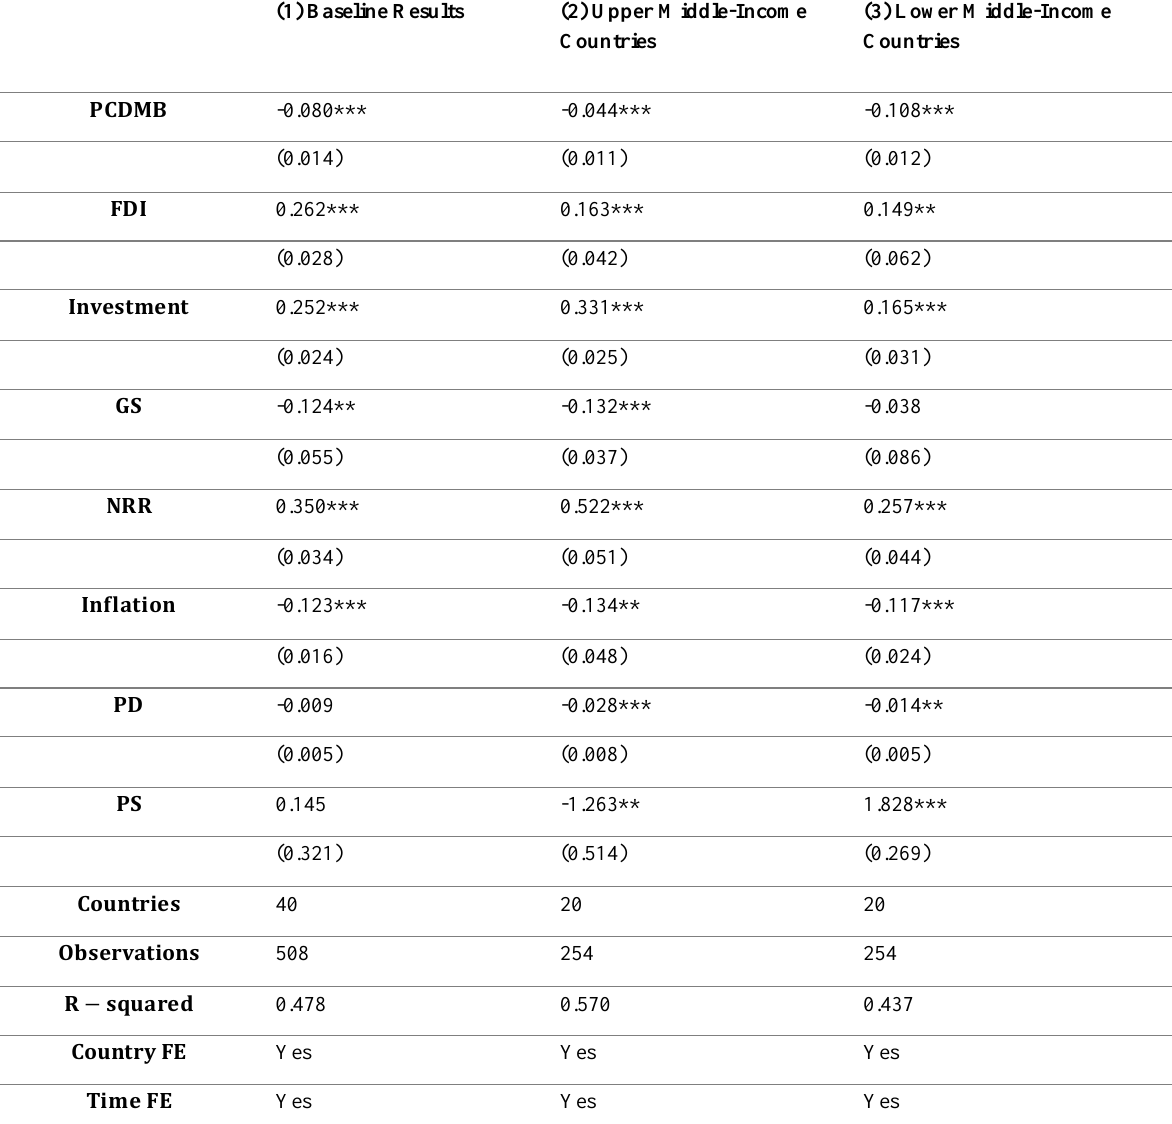
Table 2: Baseline Results, Upper Middle-Income Countries and Lower Middle-Income